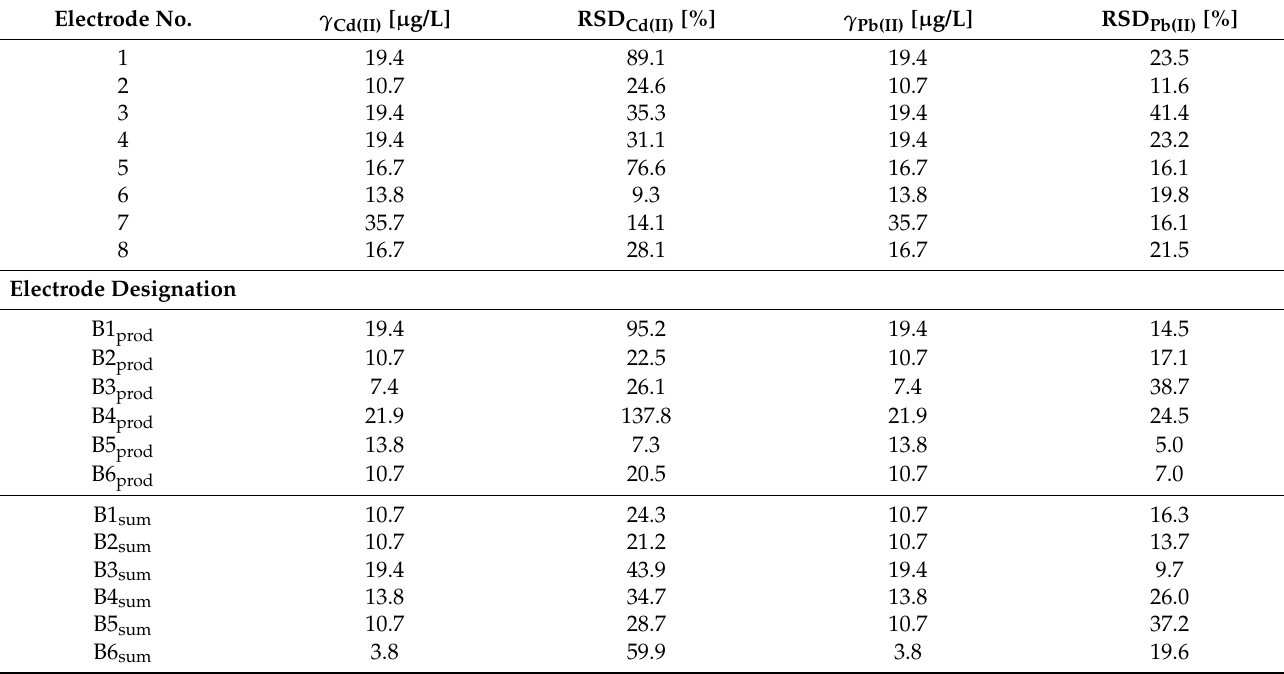
Table 8. RSD values, representing the precision of the method.